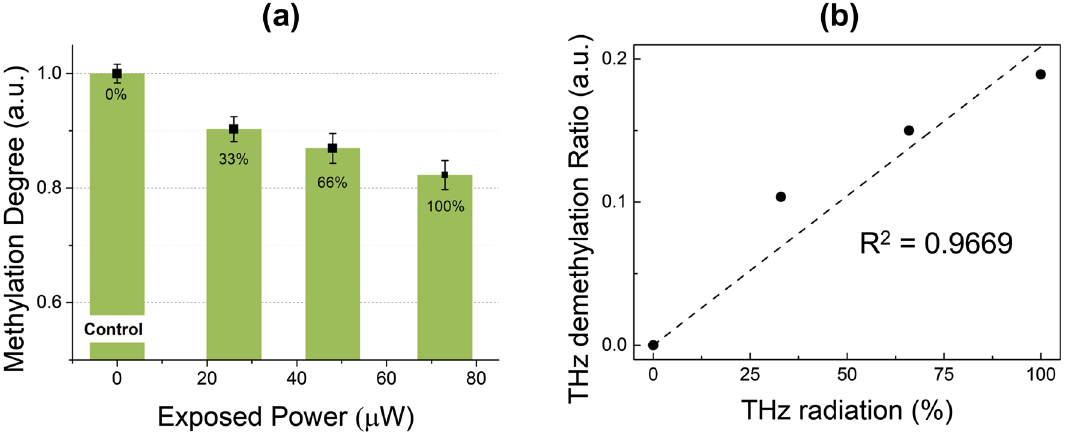
Figure 1. Power dependency of THz demethylation in living SK-MEL-3 melanoma cells. ( a ) The methylation degree decreased with the increasing power of resonant THz radiation. ( b ) The relationship between